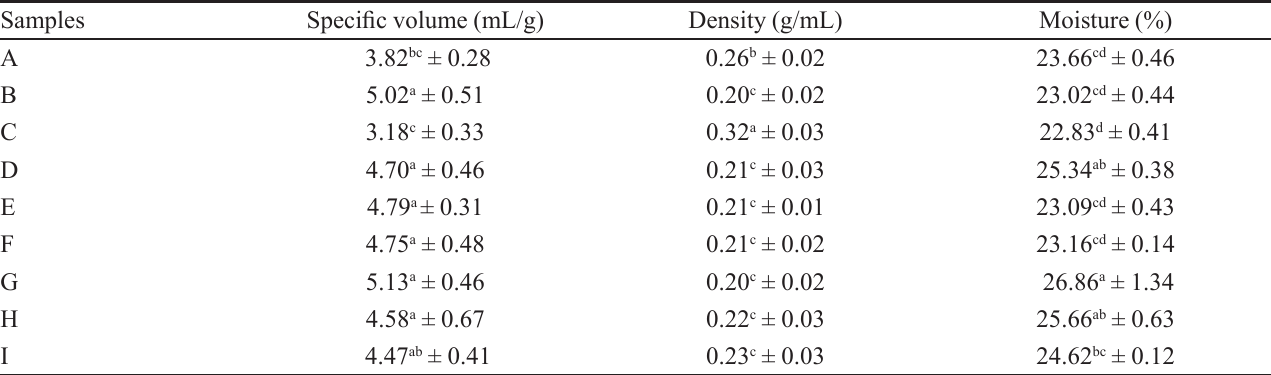
TABLE I - Specific volume, density, and moisture content of panettone samples